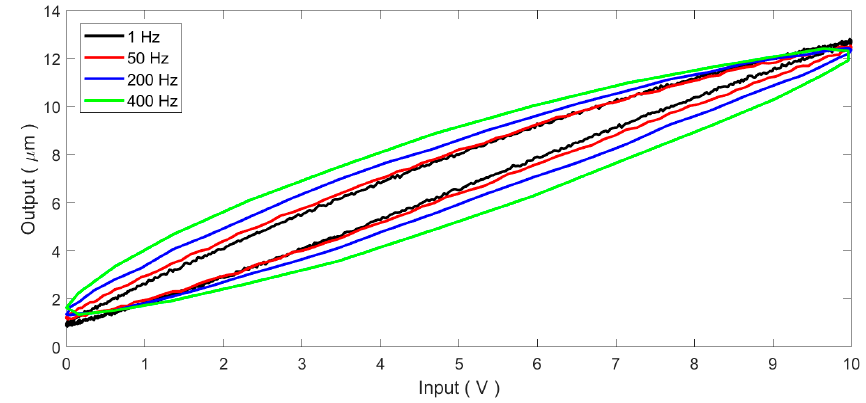
Figure 2. The measured hysteresis loops of the standalone PEA.